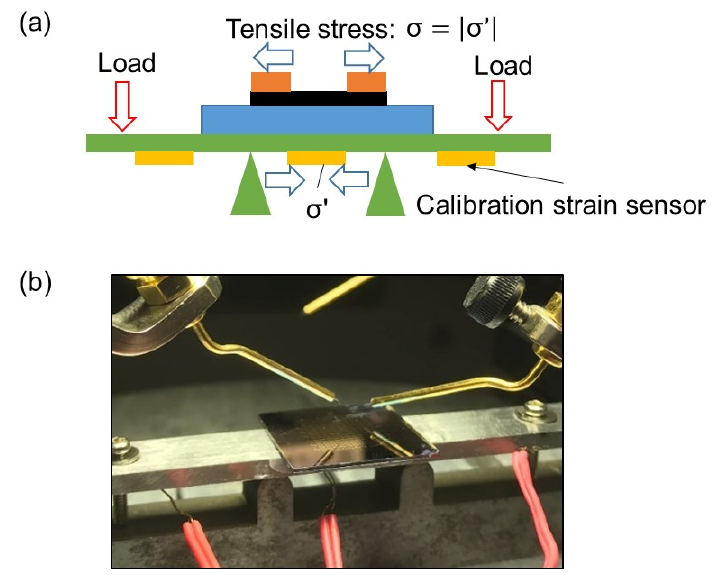
Figure 7. ( a ) Schematic of the four-point bending test principle, and ( b ) test setup.